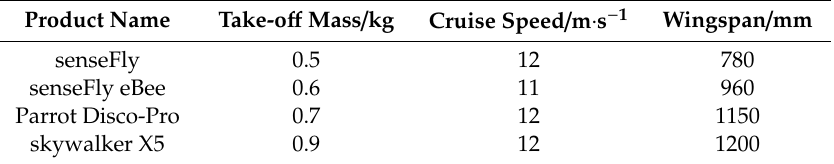
Table 1. Electric driven fixed-wing UAV parameters.